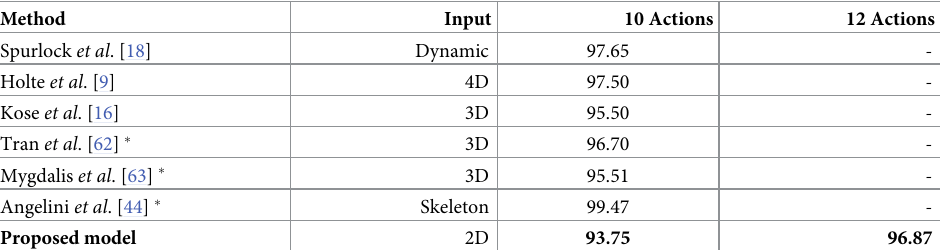
Table 4. Comparison for recognition (%) of proposed model with state-of-the-art methods on i3DPost. Method